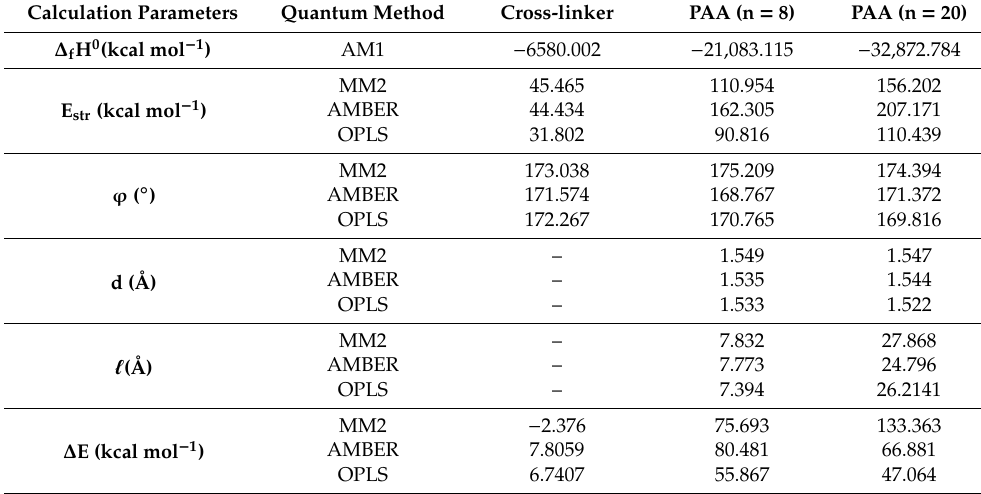
Figure 7. The optimized geometries of P (AA / Kry23-DM) SAP (n = 8 ( a ) and n = 20 ( b )) according to MM2 method. Table 1. Calculated heat of formation ( ∆ f H 0 ), strain energy (E str ), internal rotational angle ( ϕ ), the bond length (d), the lengths of the repeating unit of polymer chain ( (cid:96) ), and internal barrier energy ( ∆ E) of the stable conformations of the cross-linker and the